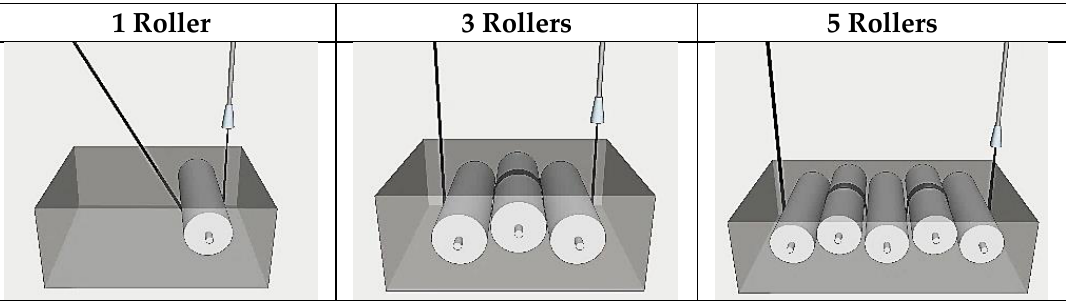
Figure 4. Schematic of the impregnation configuration depending on the number of rollers. Table 4. Yarn pulling forces during processing and mass/length ratios of freshly impregnated yarns depending on the number of rollers: average values, standard deviations in parentheses. Feature Force [N] Mass [g/m] High deflection + Freely